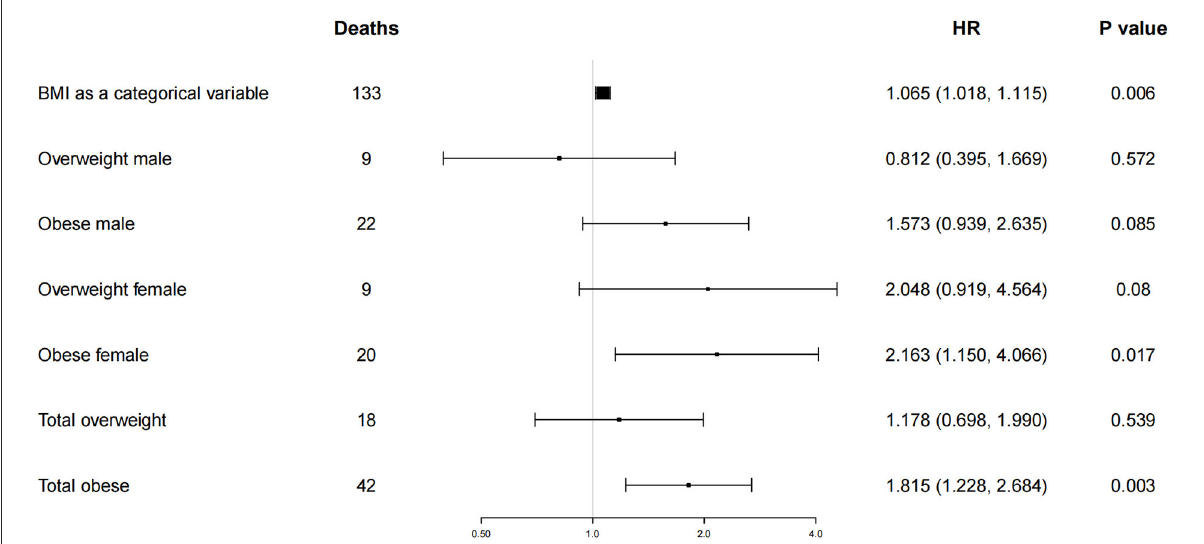
FIGURE3 Risk of cardiovascular death in overweight and obese subjects according to body mass index category at baseline examination. I bars represent the 95 percent confidence intervals for the hazard ratios. Hazard ratios were adjusted for age, smoking status, alcohol use, hypertension, hyperlipidemia, diabetes, coronary heart disease, atrial fibrillation, previous stroke, chronic obstructive pulmonary disease, renal insufficiency, New York Heart Association functional class, myocardial infarction, and percutaneous coronary intervention at base line. Normal weight (body-mass index,18.5 to 24.9) was the reference